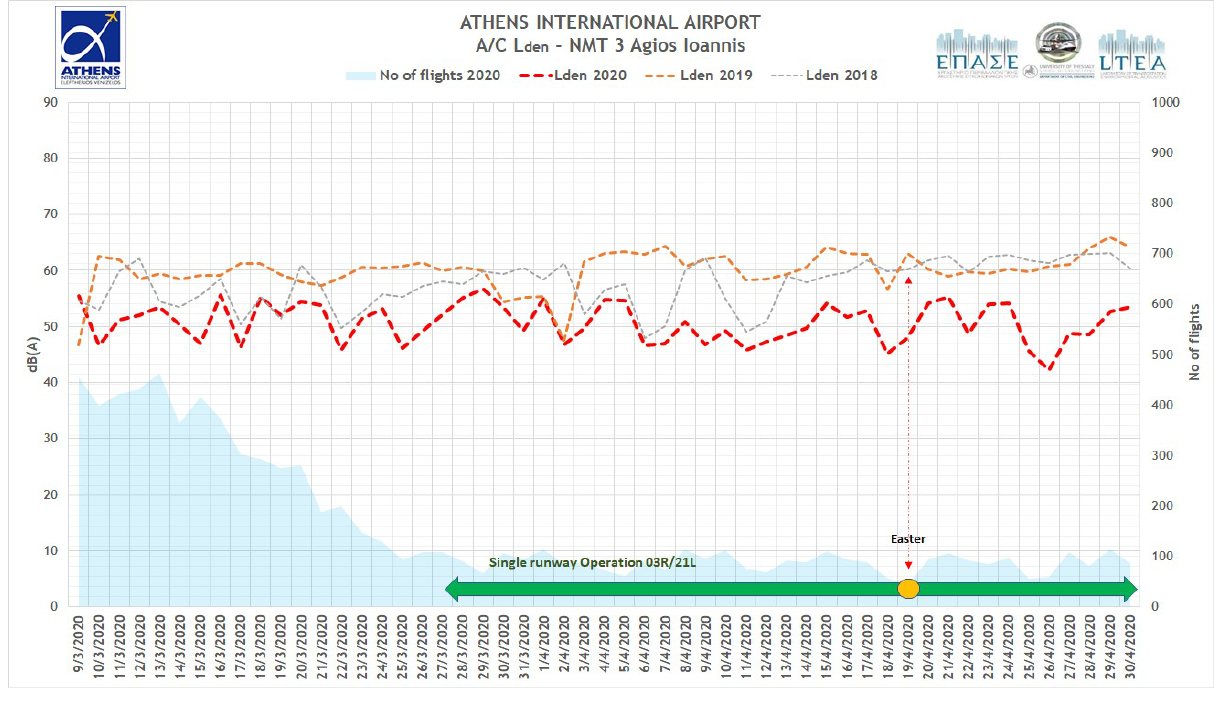
Figure 11c: Fluctuation of L den index – Noise monitoring station NMT 3 (Agios Ioannis)